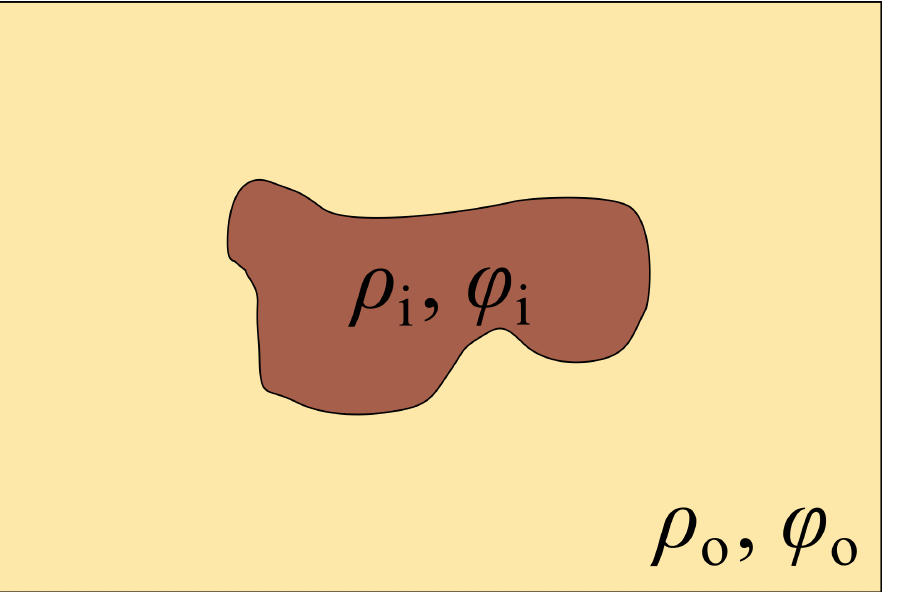
Figure 1. A target i with the electrical properties resistivity ρ i and phase shift ϕ i is embedded in a medium o with the properties ρ o and ϕ